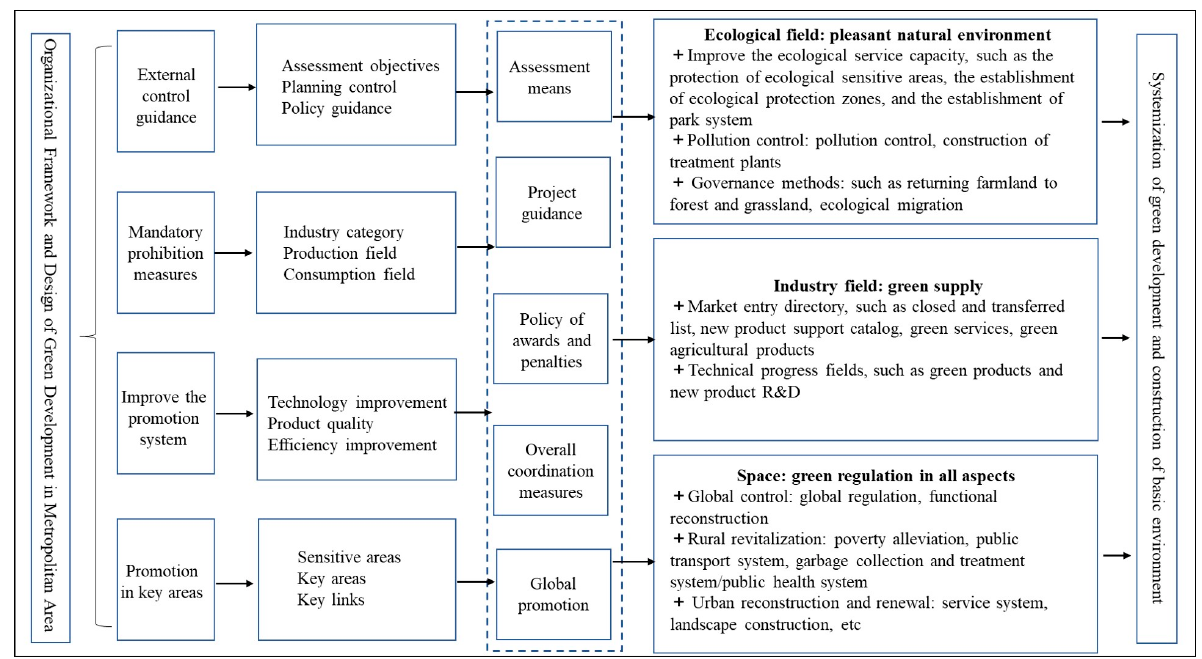
Figure 4. Organizational System and System Design of Green Development Transformation in the XMA.